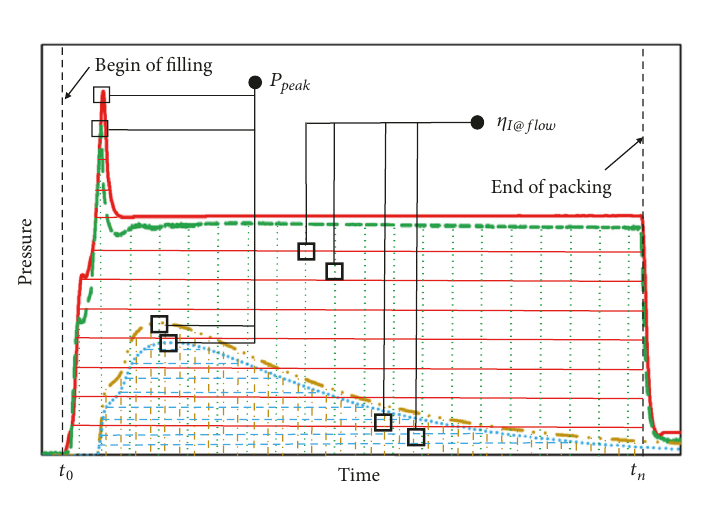
Figure 1: Peak pressure and viscosity